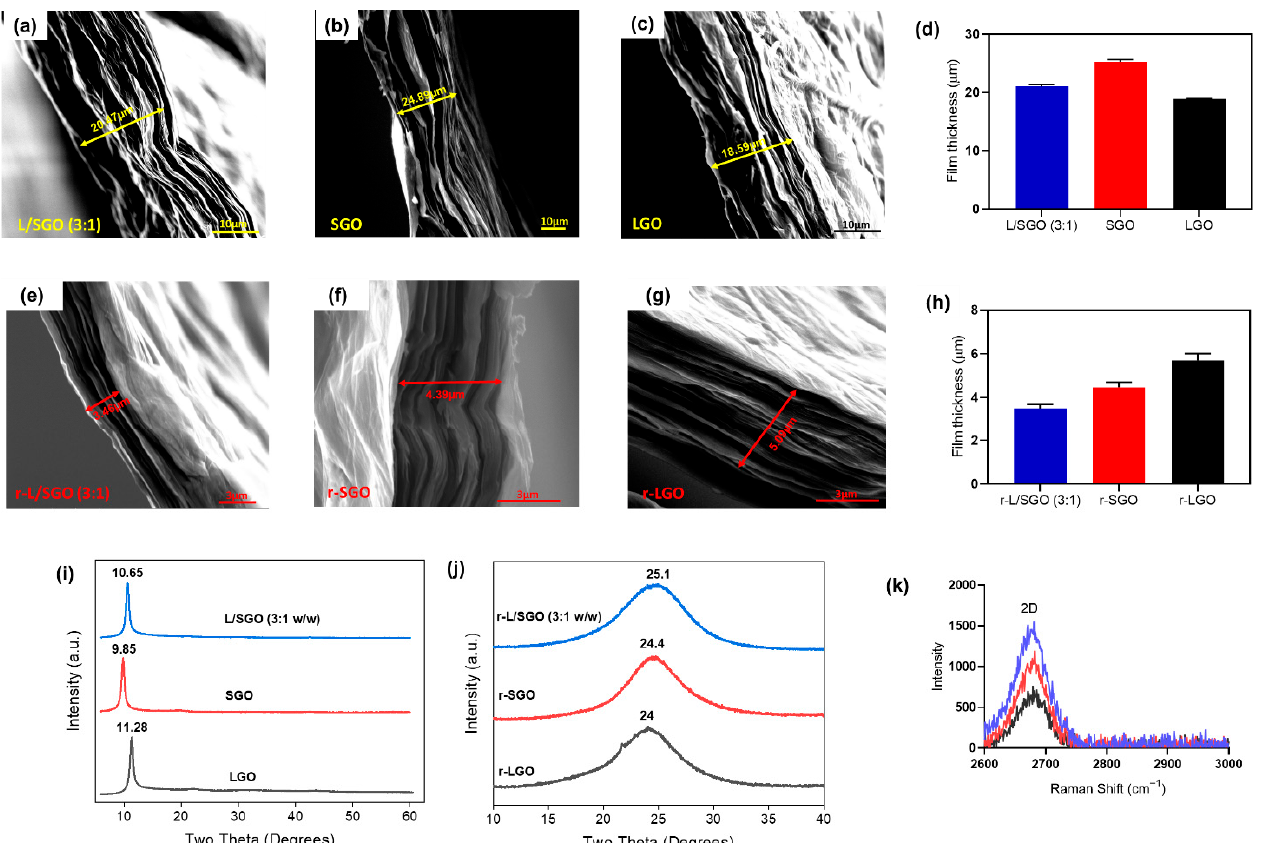
Figure 5 . Structural characterization of different GO and rGO films. ( a – c ): FESEM images of the cross-section of L/SGO (3:1), SGO, and LGO films, respectively. ( d ) Bar chart plot of cross-sectional film thickness for various GO. ( e – g ): FESEM images of the cross-section of r-L/SGO (3:1 w / w ), r-SGO, and r-LGO films, respectively. ( h ) Bar chart plot of cross-sectional film thickness for various rGO. ( i ) XRD spectra of various GO films. ( j ) XRD spectra of various rGO films. ( k ) Raman spectra 2D band of various rGOs. The error bars represent SEM with n = 3. All rGO films ware prepared use HI acid as reductant. A comparative study using L-ascorbic acid reductant was shown in Figure S5.